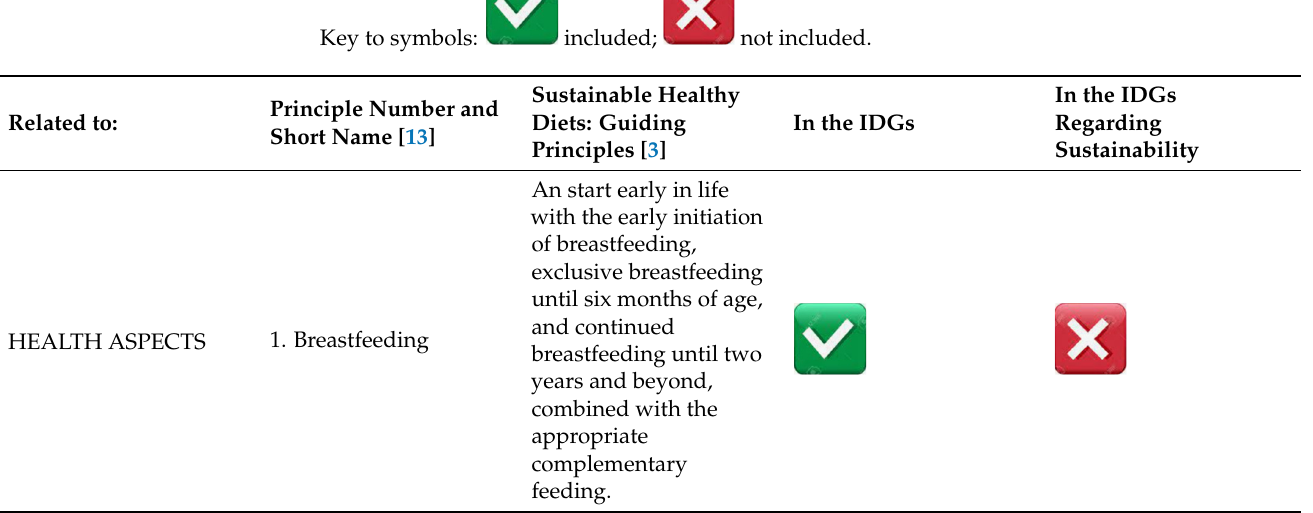
Table 1. The 16 guiding principles of a sustainable healthy diet in the IDGs regarding sustainability. Key to symbols: